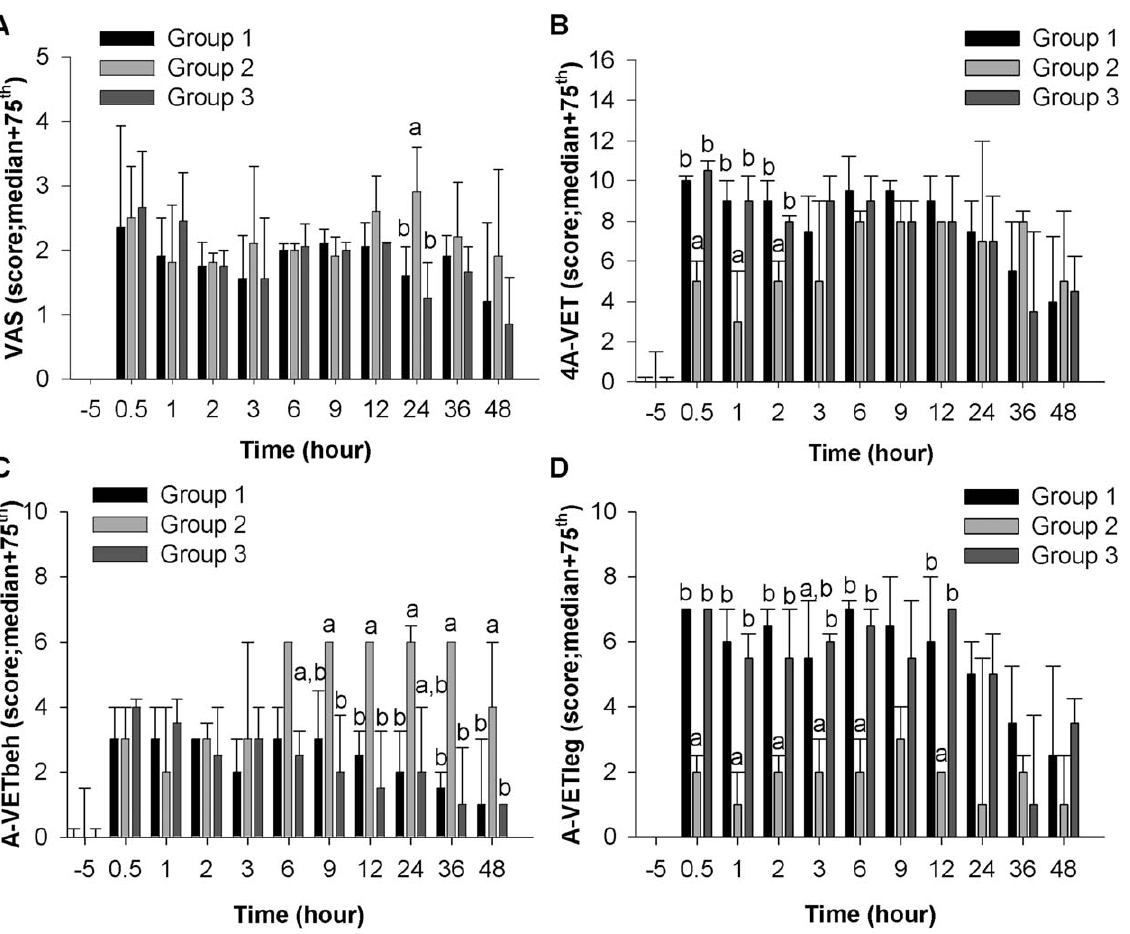
Figure 2. Pain scales. A) Visual analogue scale, B) the 4A-VET pain scale, C) 4A-VETbeh subscale, and D) 4A-VETleg subscale by group over time. Data are presented as the median and 75 th percentile for groups of n=5 to 10 dogs at each time points. At each time point, different letters